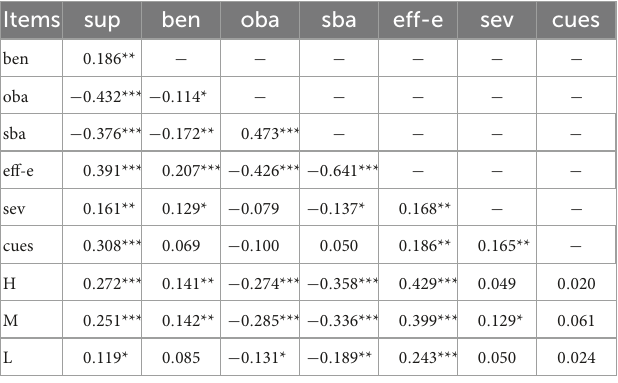
TABLE 3 Relationship between peer support, Health Belief Model Scale for Exercise, and physical activity (PA) ( n = 336). Items